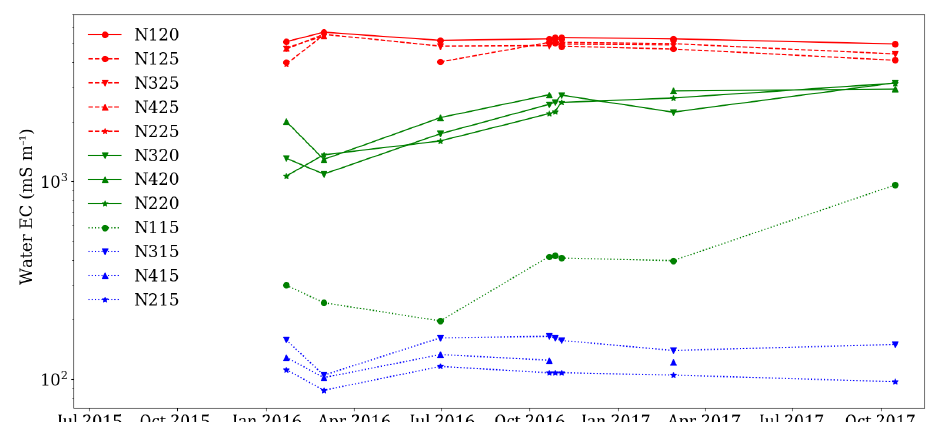
Figure 10. Water electrical conductivity measurements taken on water samples from piezometers in nests N1, N2, N3 and N4. The piezome- ters are grouped according to the elevation of the screened intervals: “upper” (blue, − 7 to − 10ma.s.l.), “transition” (green, − 11 . 5 to −